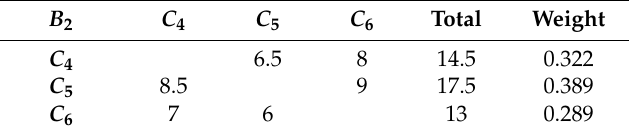
Table A3. Judgment matrix of C 4 – C 6 .